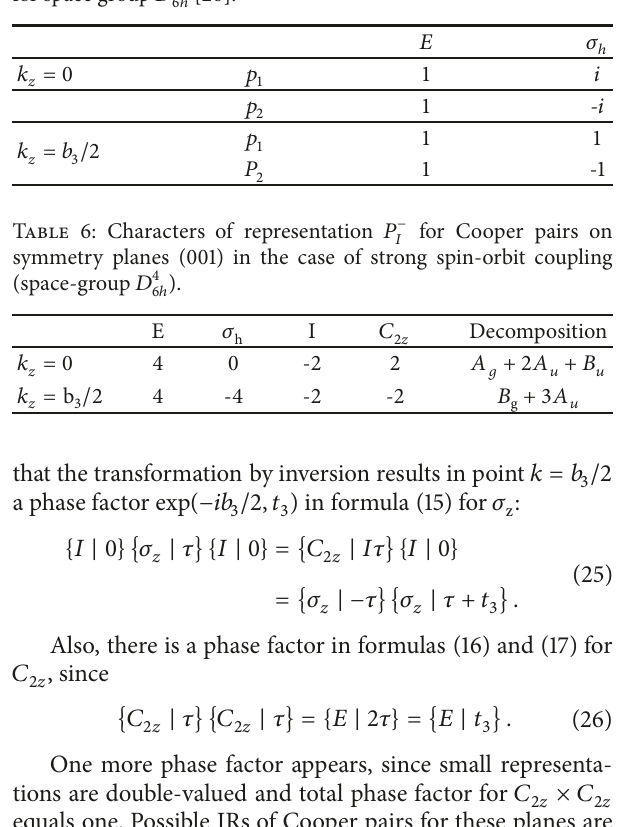
Table 5: Double-valued IRs on the (001) planes of symmetry of BZ for space group 𝐷 4 6ℎ [26].